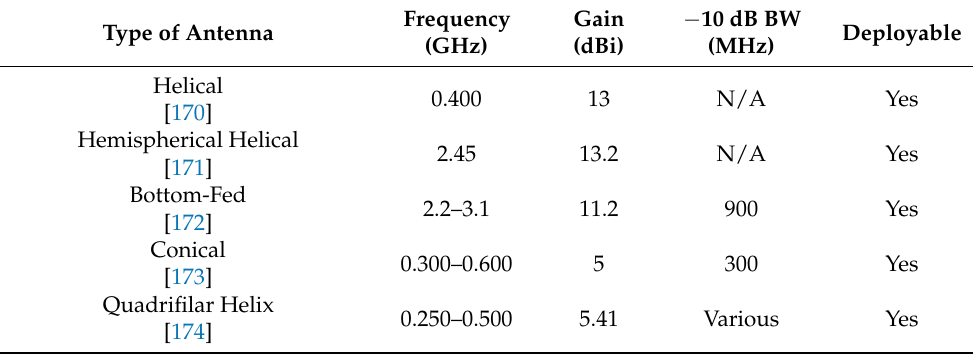
Table 9. Performance of conical spiral and helical